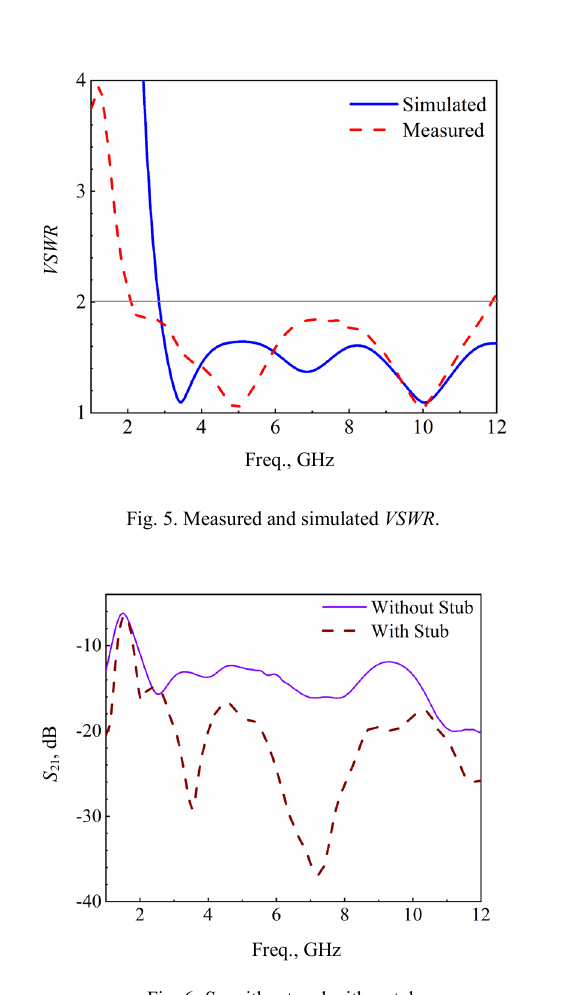
Fig. 7. Surface current at (a) 4.5 GHz, (b) 5.8 GHz.